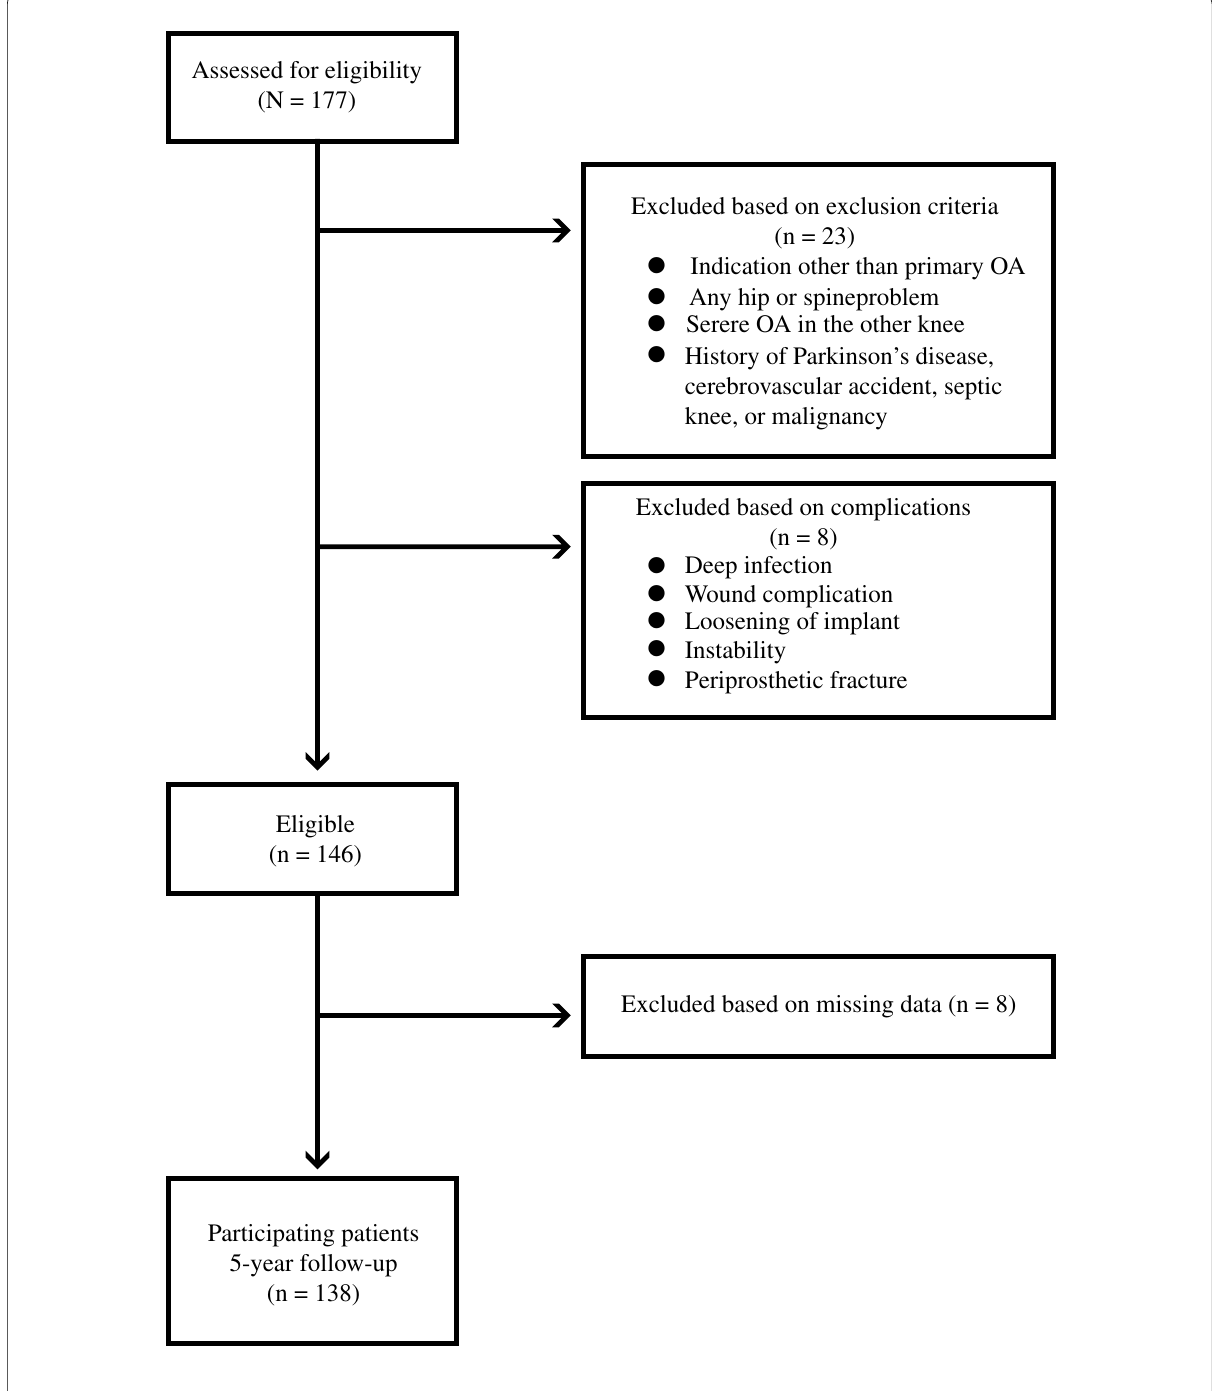
Fig. 1 Flowchart showing details of patient enrollment and